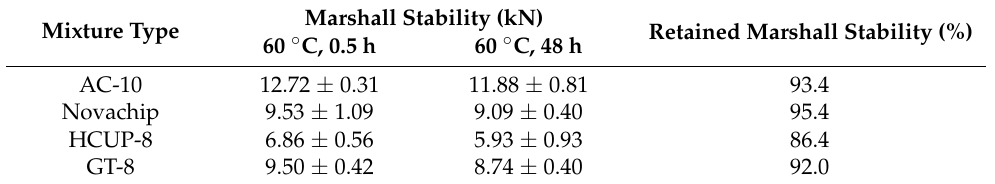
Table 9. Tensile strength test results.